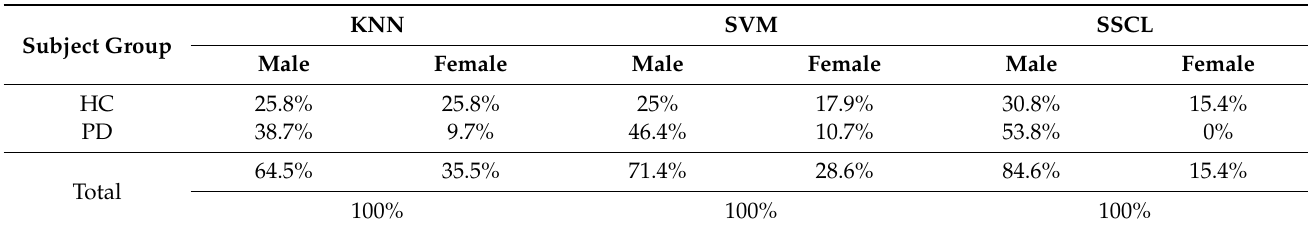
Table 5. Summary of the misclassified voice records in percentage and their corresponding subject group and gender